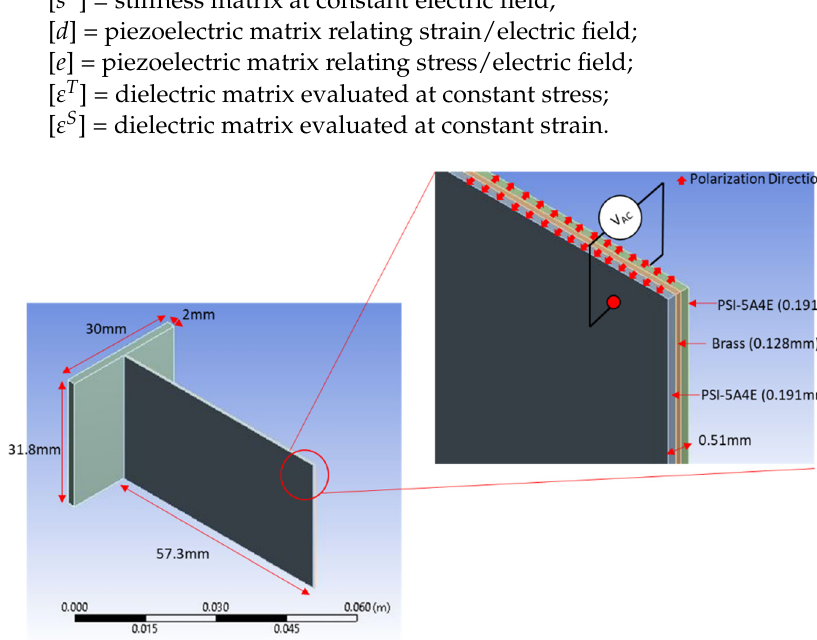
Figure 7. Dimensions and construction of bluff splitter body and PVEH plate. Table 4. Material properties of PVEH plate